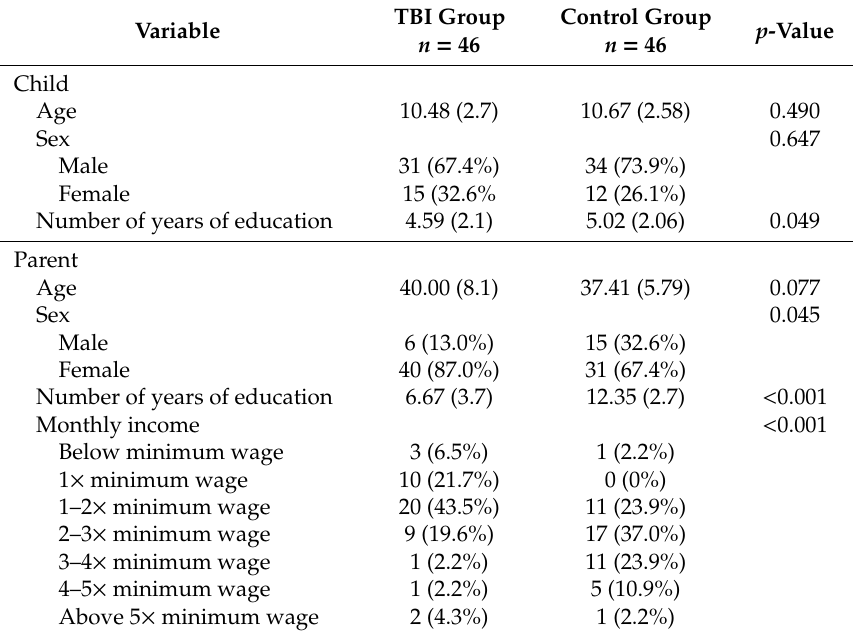
Table 1. Demographics by